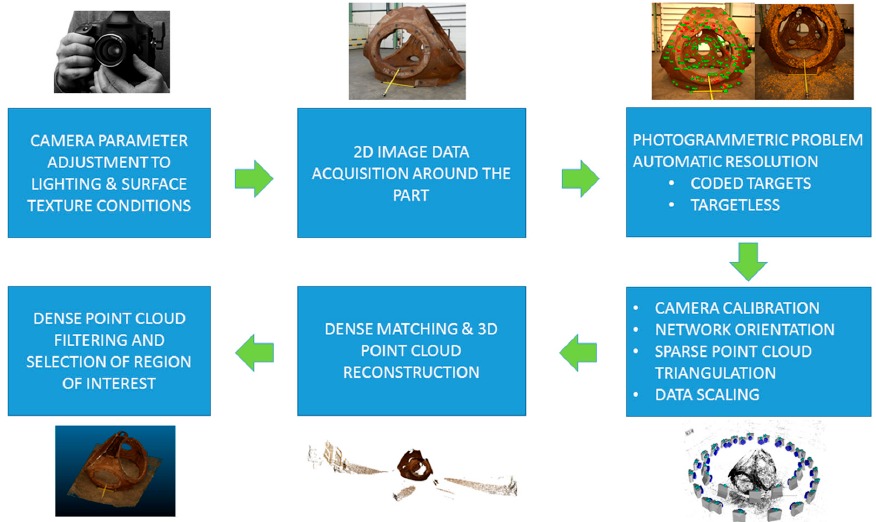
Figure 5. Dense matching process detailed workflow for shop-floor case study.